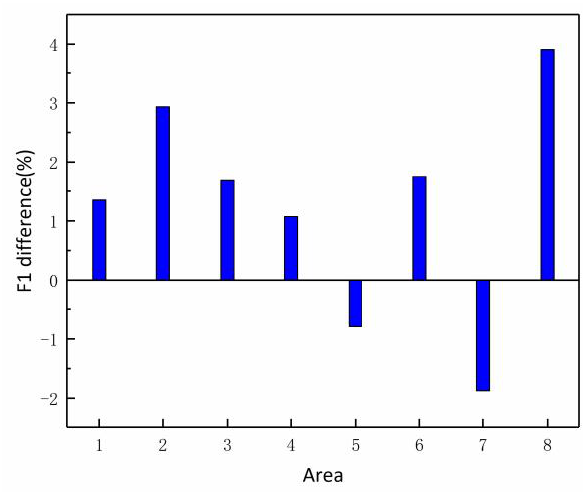
Figure 18. F1-score difference between DTRM and PRM in eight experimental subregions.